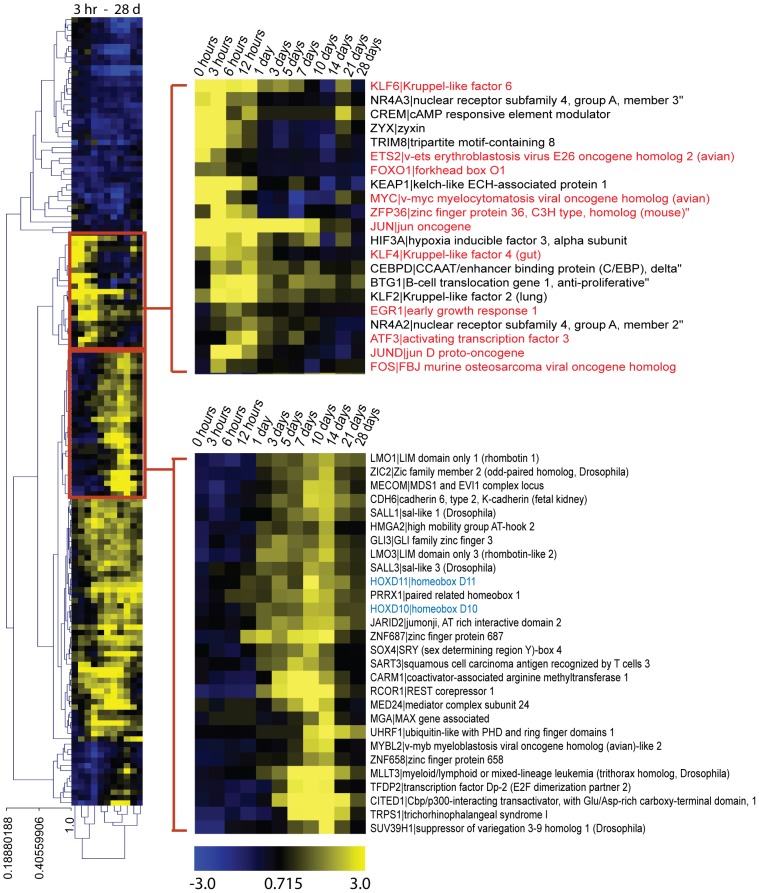
Two-way clustering of all differentially expressed (DE, FDR<0.05) transcription factors (TFs).Differential expression is relative to the zero hour control. Upper right: an early upregulated cluster of TFs dominated by oncogenes (ATF3, KLF4, KLF2, JUN3, EGR1, NR4A2, and FOS are all oncogenes). Oncogenes are highlighted with red text. Lower right: a cluster of TFs upregulated later in the time course including genes involved in limb development such as HOXD10 and HOXD11 (highlighted in blue text). Clustering and viewing was done with Mev 4.8.1 The distance measure used was the Pearson uncentered correlation with average linkage.